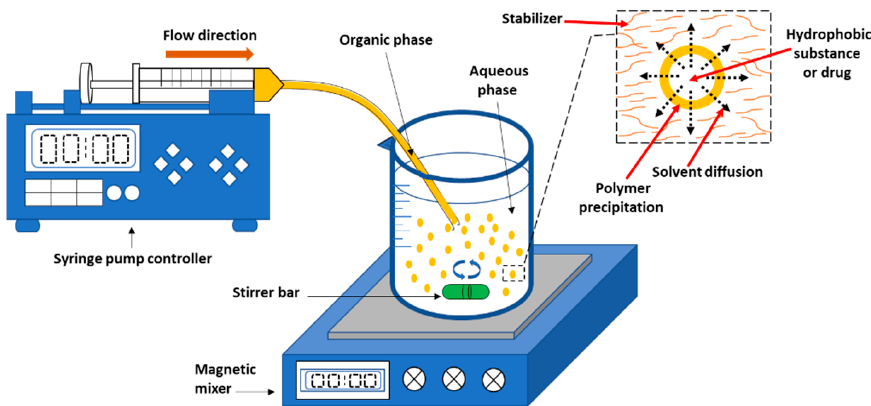
Figure 1. The nanoprecipitation process illustrated in a diagram . The enlarged image (inset) illus- trates the process of nanoparticle (yellow spheres) formation owing to the surface tension difference between the aqueous phase (high surface tension) and organic phase (low surface tension). Adapted from Wang et al. (2016) [78].